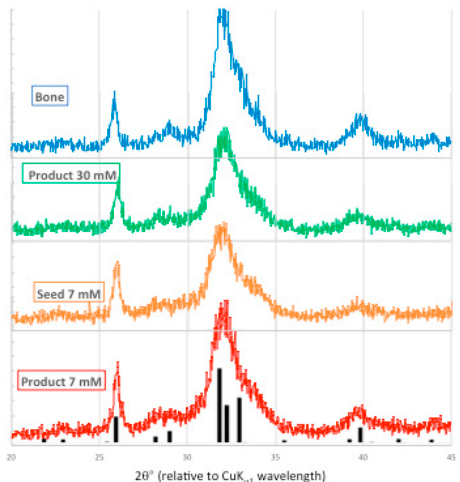
Figure 9. X-ray powder diffraction patterns from bone mineral (blue), 30 mM [Pi] unseeded experiment (green), 7 mM [Pi] seed (orange) and seeded precipitate (red), overlaid with ICDD 01-089-4405 PDF (hydroxyapatite, black).